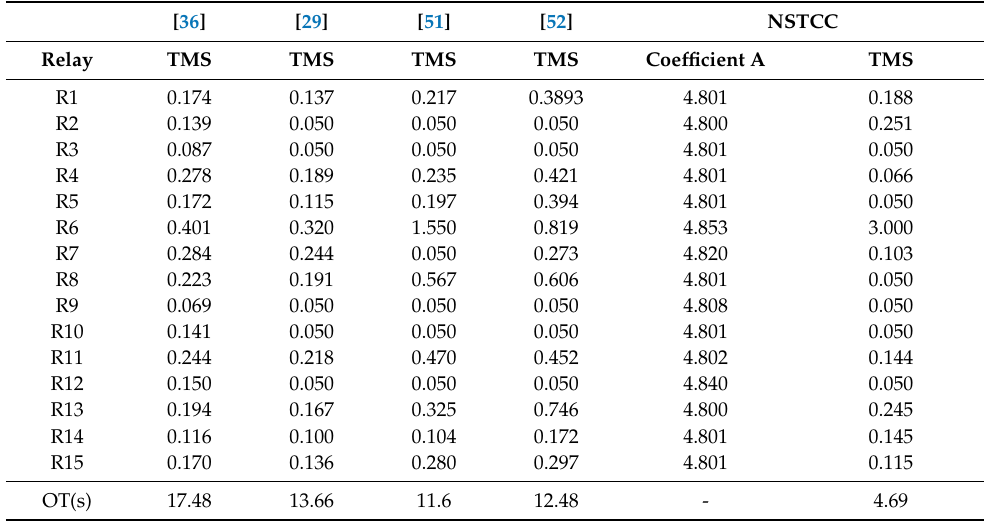
Table 7. The Overall OT for the radial IEC MG—Mode 2.